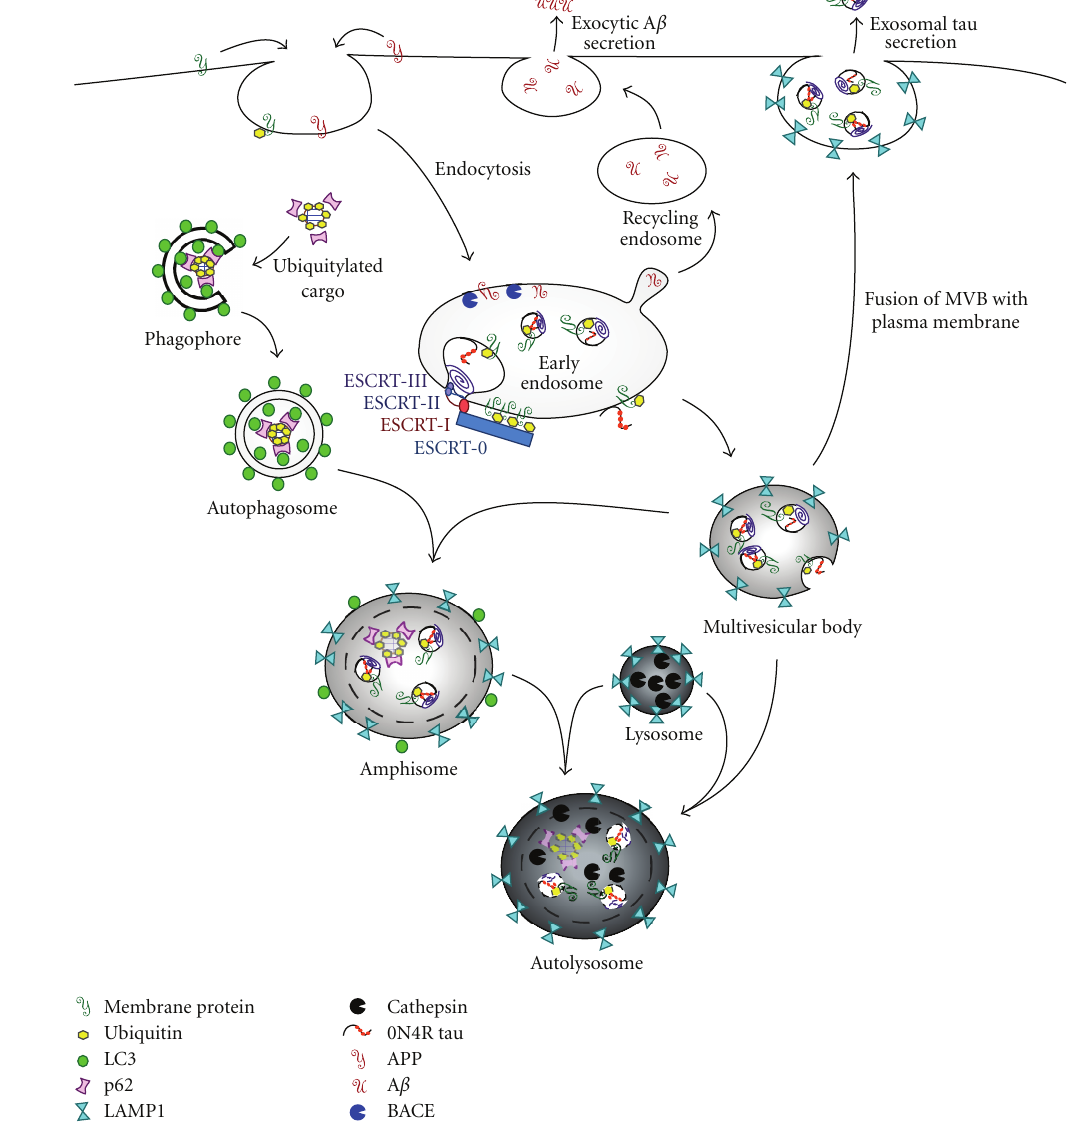
Figure 1: Intracellular vesicular tra ffi cking pathways. Endocytosed surface proteins, such as APP, are delivered to the endosomal system by internalization. Internalized membrane proteins can be sorted into intralumenal vesicles of the MVB by sequential activity of ESCRTs 0, I, II, and III or delivered to the extracellular environment by the recycling endosome. Mature MVBs fuse with either the autophagosome of the autophagic pathway to form the amphisome or directly with the lysosome, which donates degradative hydrolases, creating the autolysosome where complete degradation of the sequestered material occurs. Alternatively, the multivesicular body can fuse with the plasma membrane, resulting in the exosomal secretion of the intralumenal vesicles and their internalized